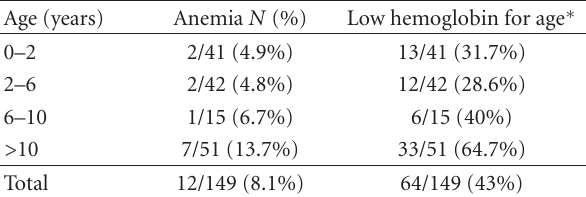
Table 3: Anemia and low hemoglobin for age in age groups.